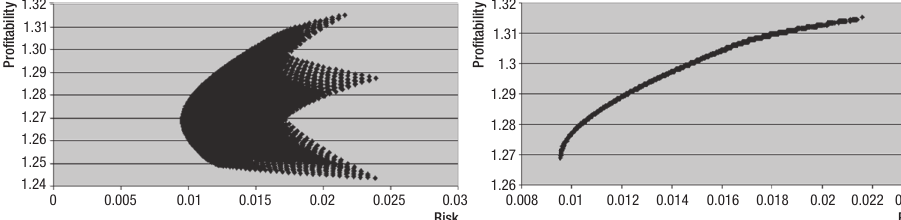
Fig. 6. Visualization of (4)–(6) problem solving, when distributions D assumed to be correlated random variables with the same a proportions among separate P